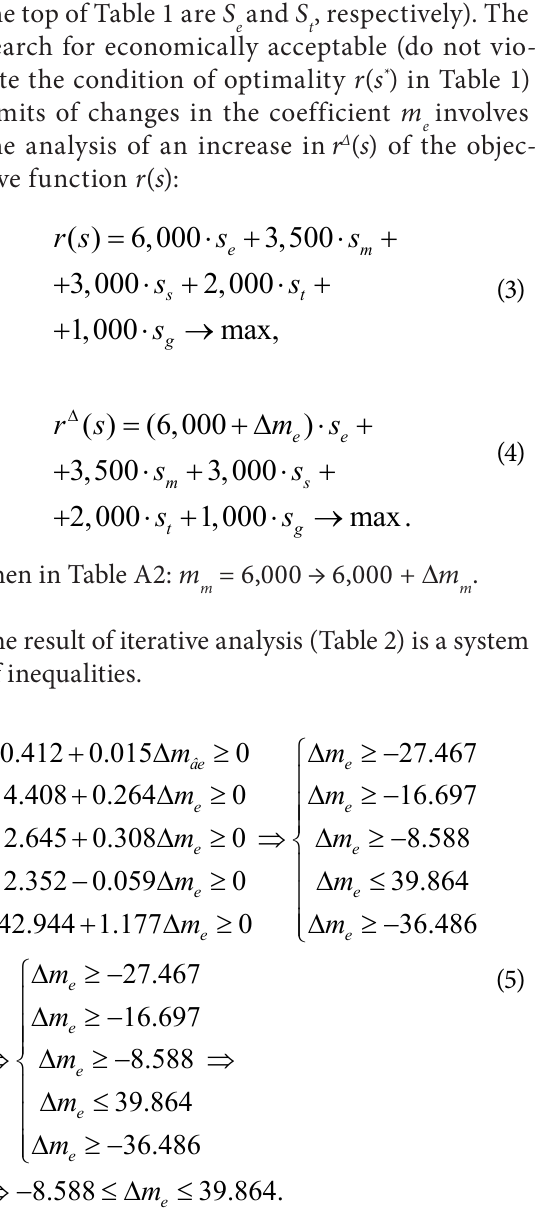
Table 2. Analysis of changes in the price of “wow-effect” of nature tourism services in the final iteration of